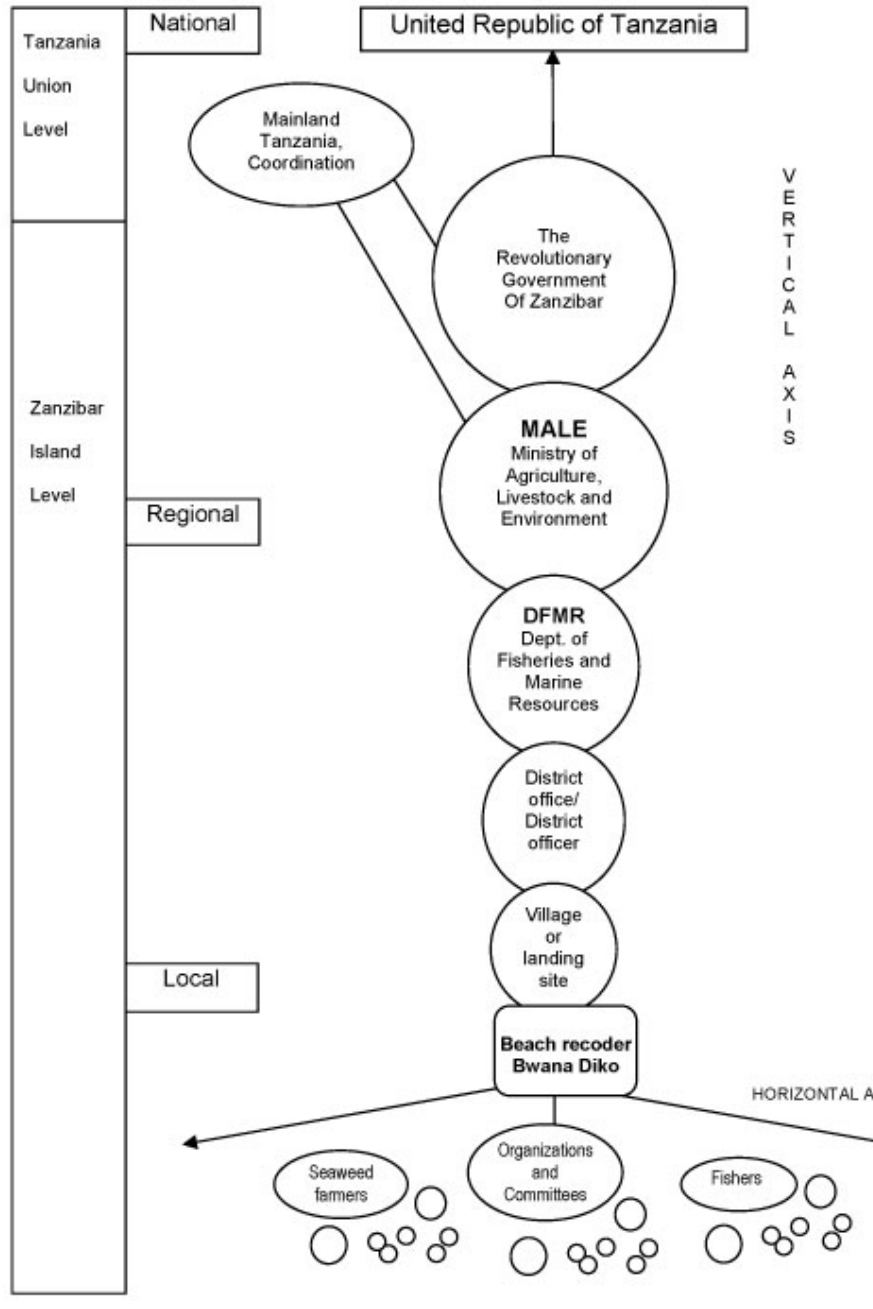
Fig. 1. The nested organizational structure for the management of marine resources in Zanzibar,